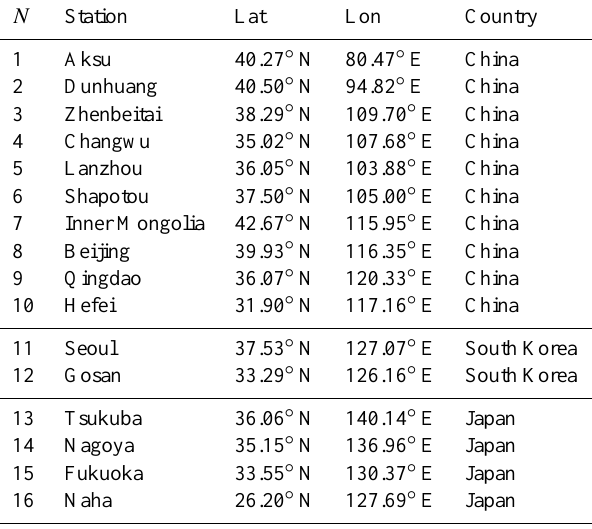
Table 5. Asian stations to derive the dust surface concentration from visibility in spring of 2000 and 2001. Stations are divided into three groups according to the country. N is the number of each station as shown in Fig. 6.